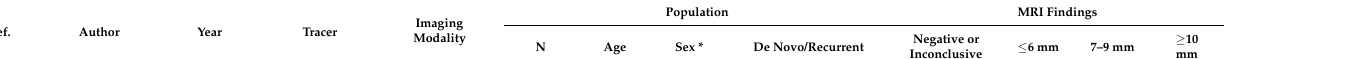
Population: histologicallyprovenCushing’sadenomaafterTSS,overt ( n =20)andpreclinical( n =15) Adenomadetection: -MRImicroadenoma( n =30): -1.5T=+in8/14(57%)ofwhich preclinical: +in2/5,overt: +in6/9 -3.0T=+in4/16(25%)ofwhich preclinical: +in1/7,overt: +in3/9 12/30(40%): goodcorrelationto surgicalfindings: 10false-,6false+ and3doublepituitaryadenoma -11C-Met-PET/MRI3.0T=+in11/11